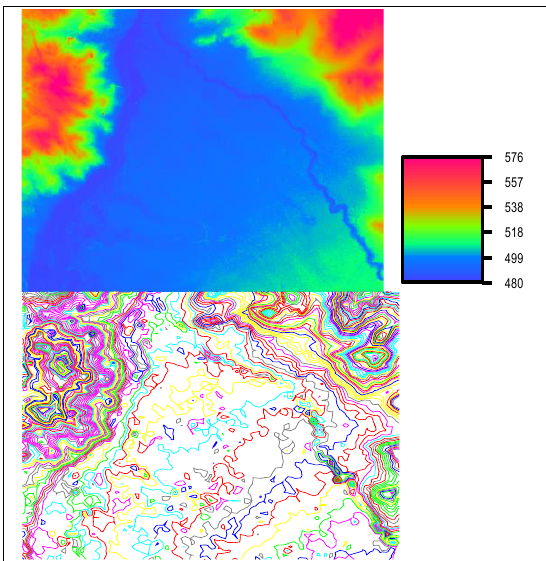
Fig (1)khartoum Digital elevation model extracted from Global DEM /Esri 2014, and fig (2) countor Elivation Ground water occurrence: